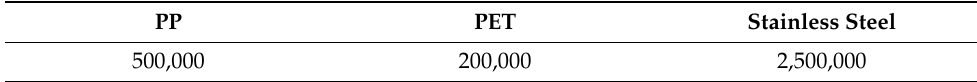
Table 28. Total product EOL waste per material type.